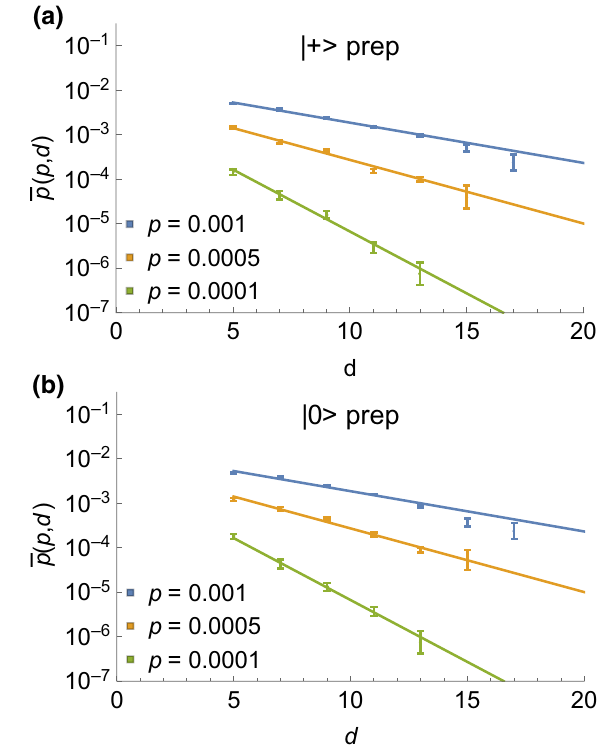
FIG. 16. Logical failure probability for preparing the |+(cid:2) and | 0 (cid:2) states. The ansatz in Eq. (7) is fitted, giving p Table I. Both plots can be fitted well using the same parameters, which justifies treating both |+(cid:2) and | 0 (cid:2) preparation identically in the noise